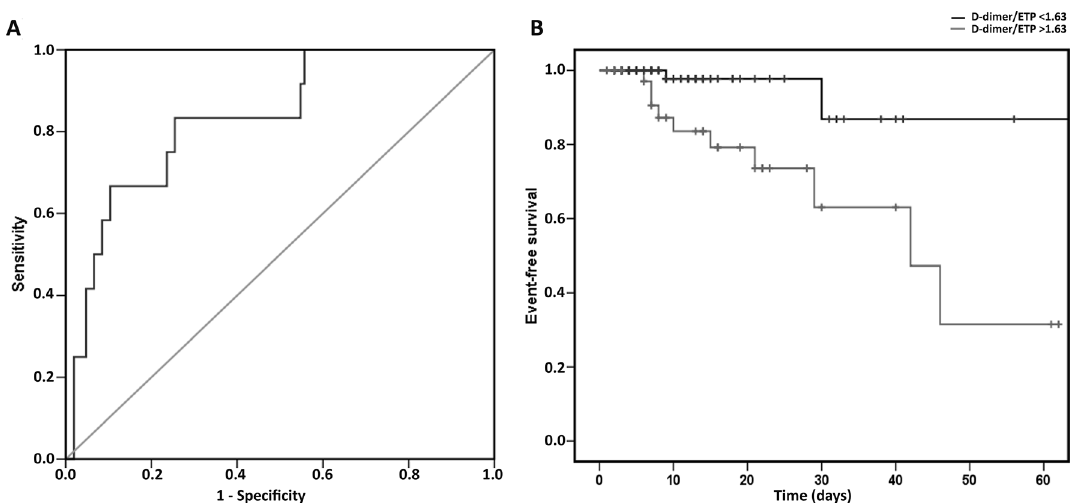
Figure 3. Ratio D-dimer/ETP as predictor for adverse events (vascular events or death) in COVID-19 patients. ( A ) ROC curve; ( B ) Kaplan–Meier